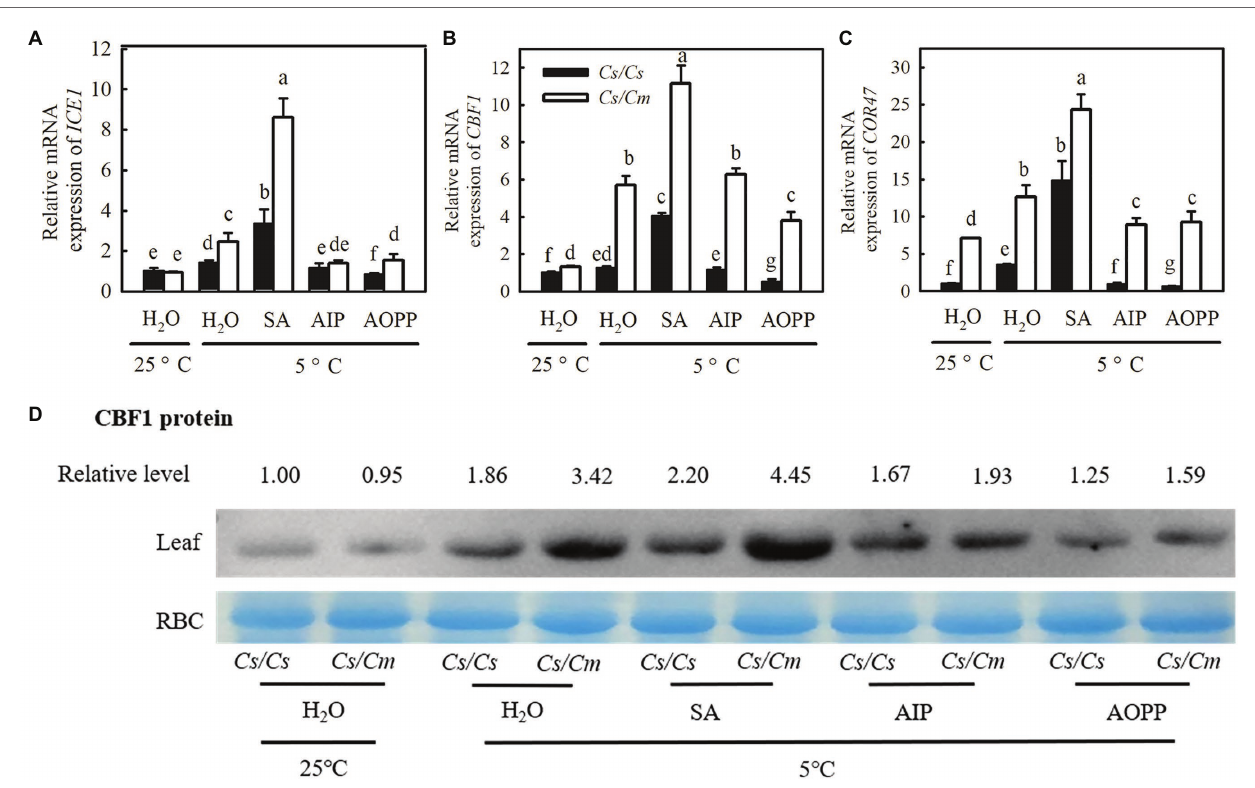
FIGURE 7 | Effect of SA on the mRNA abundance of cold-responsive ( COR ) genes and the protein level of CBF1 in Cs/Cm and Cs/Cs plants under chilling stress. (A–C) Relative mRNA expression of ICE1 , CBF1 , and COR47 . Plants were foliar sprayed with 1.0 mM SA, 0.03 mM AIP, 0.1 mM AOPP, or deionized water (H 2 O, control) for 24 h and then exposed to 5 ° C stress for 48 h. (D) CBF1 protein accumulation in seedlings after exposure to 5 ° C for 24 h. Data are the means of four replicates (±SDs). Different letters indicate significant a difference between samples according to Duncan’s new multiple range test ( p <